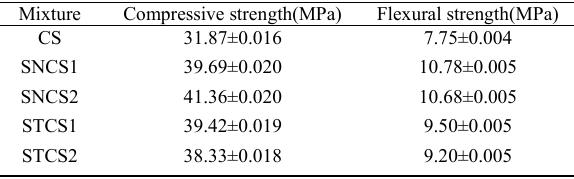
Table 4. Results of compressive and flexural strength (MPa).